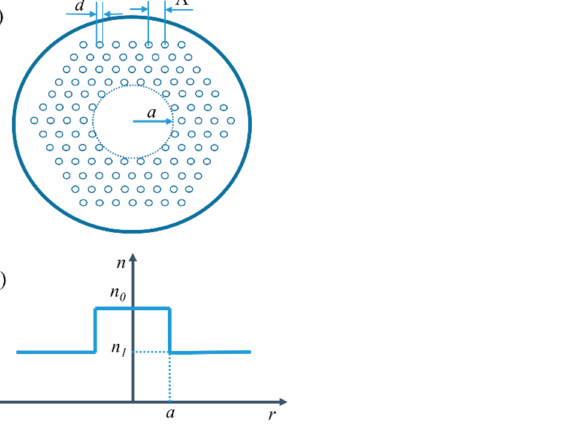
Figure 1. ( a ) Lateral end-face of a solid-core multimode SI PCF, where Λ is the pitch and d is the diameter of the air holes. ( b ) RI profile of a multimode SI